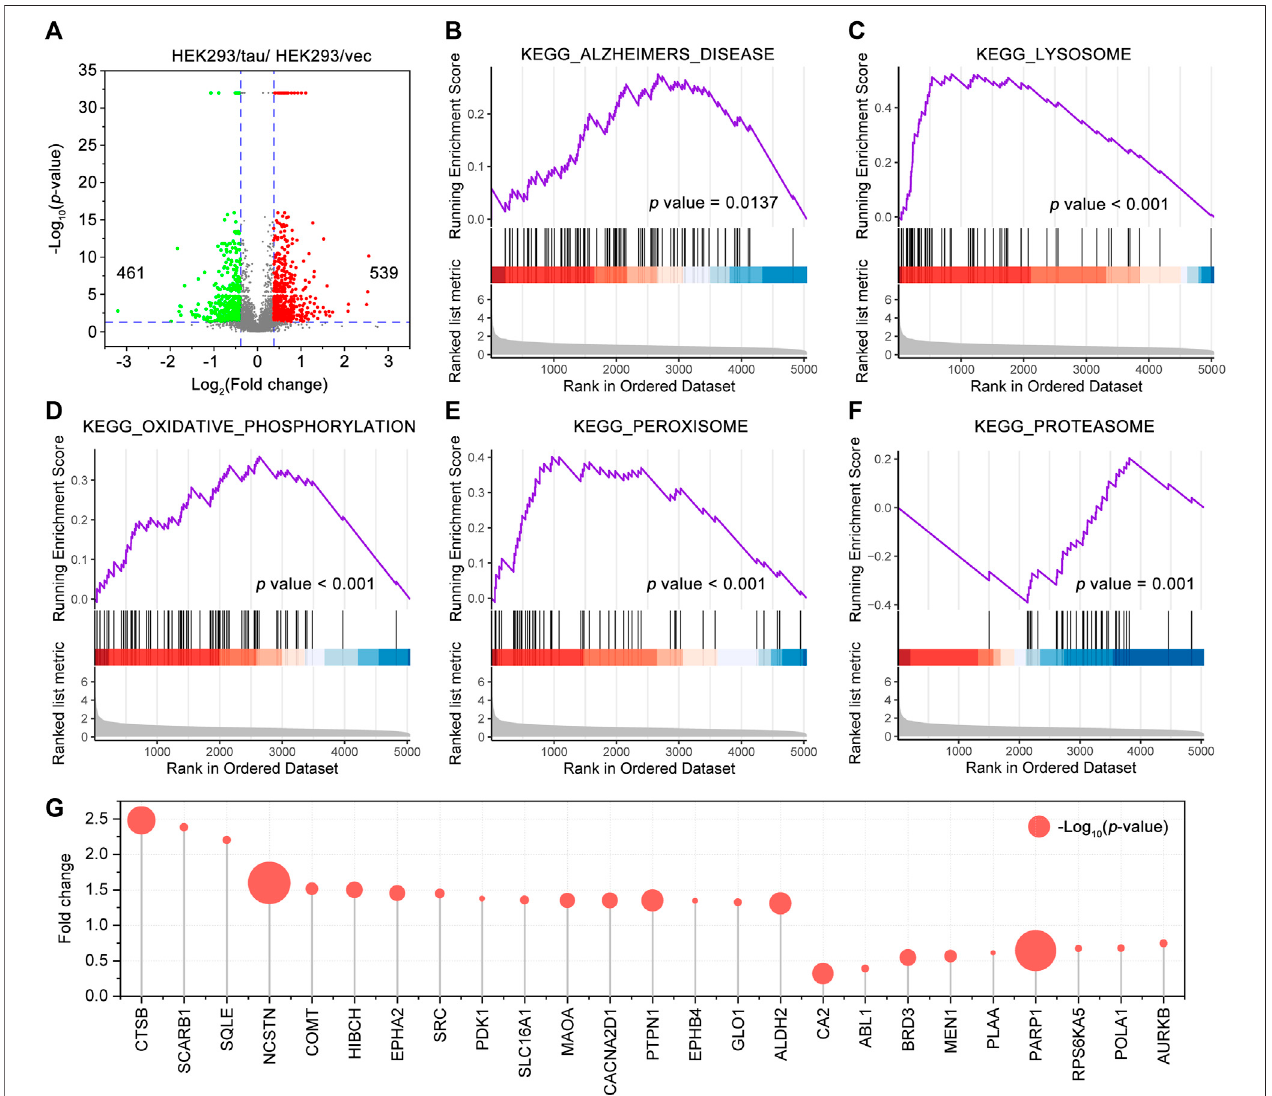
FIGURE4| Genesetenrichmentanalysis(GSEA)oftheproteinsinHEK293/taucells(stableoverexpressinghumanwild-typefull-lengthtau)andHEK293/veccells. (A) Volcano plot showing the differentially expressed proteins, which were as differentially expressed when fold change > 1.3 and p < 0.05, between HEK293/tau cells and HEK293/vec cells. GSEA of the proteins identi fi ed by proteomics. KEGG_ALZHEIMERS DISEASE (B) , the KEGG LYSOSOME (C) , KEGG OXIDATIVE PHOSPHORYLATION (D) , KEGG PEROXISOME (E) , and KEGG PROTEASOME (F) were signi fi cantly enriched. (G) The common proteins of the differentially expressed protein data set (HEK293/tau vs HEK293/vec cells) and CR target data set. The size of each bubble point represents the corresponding p value.